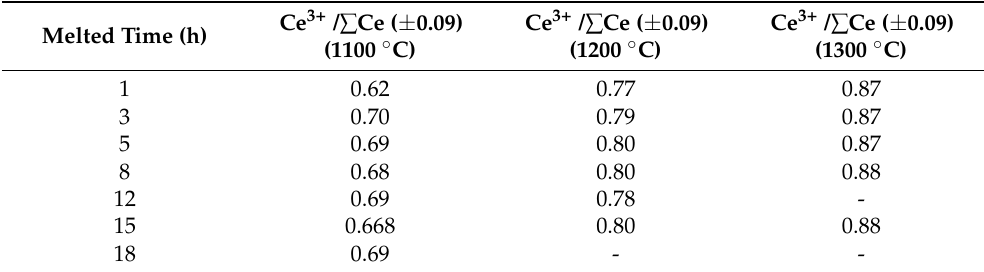
Table 3. The concentrations of Ce 3+ with different melting times at different temperatures for S5NBCe Table 2. The concentrations of Ce 3+ and Ce 3+ /Ce 4+ ratio within the processed glasses Na 2 O·2B 2 O 3 1 glass melted with sodium tetraborate melted with different amounts of CeO 2 .